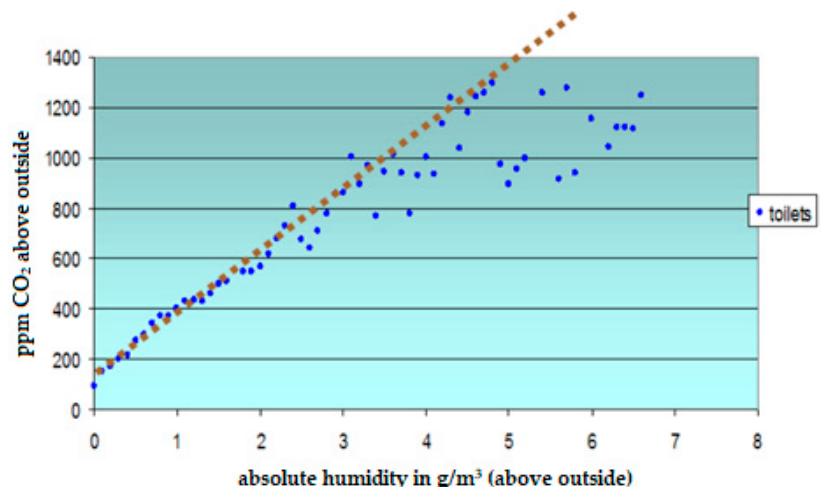
Figure 11. Correlation between CO 2 and absolute humidity in toilets [76]. Buildings 2018 , 8 , x FOR PEER REVIEW